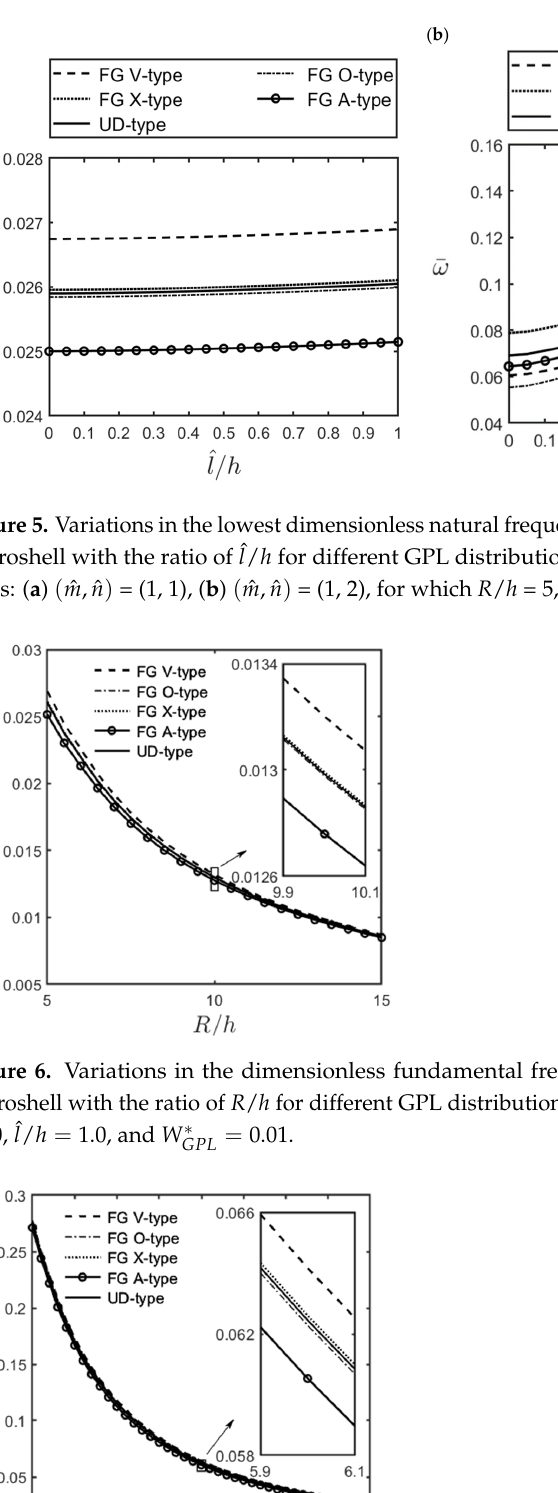
( ) ˆ ˆ, ( ) ˆ ˆ, m n = (1, 1), R / h m n = (1, 1), R / h